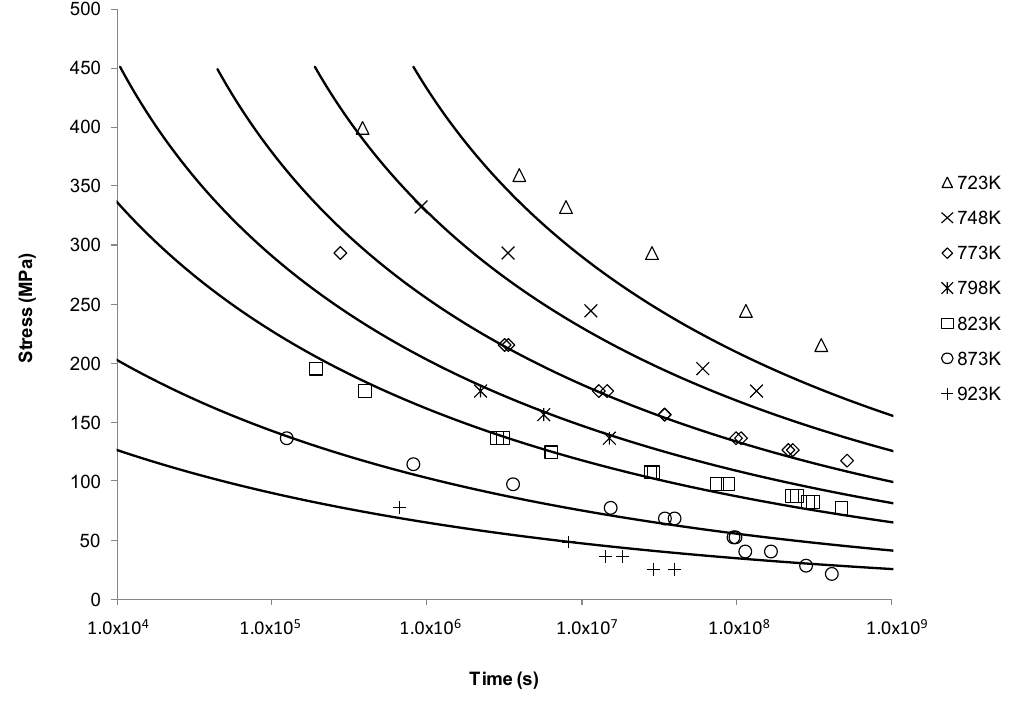
Figure 8. The stress vs . time to fracture curves of Soviet Model 2 using Grade 22 Steel creep